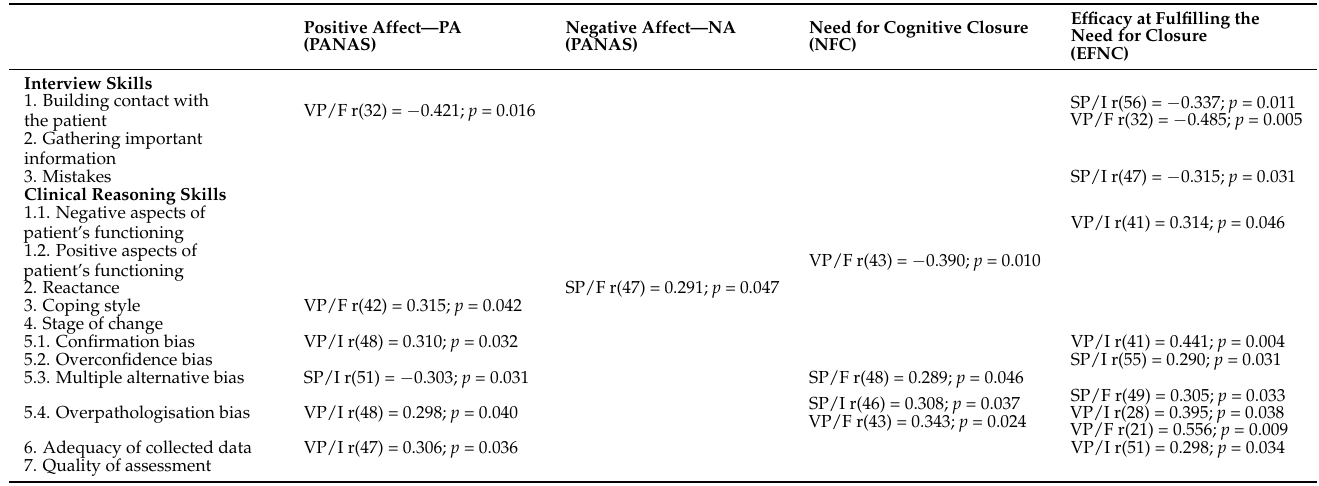
Table 1. Relationships between affect, need and efficacy at fulfilling the need for closure of diagnosti- cians and psychological assessment skills learnt through the use of simulated and virtual